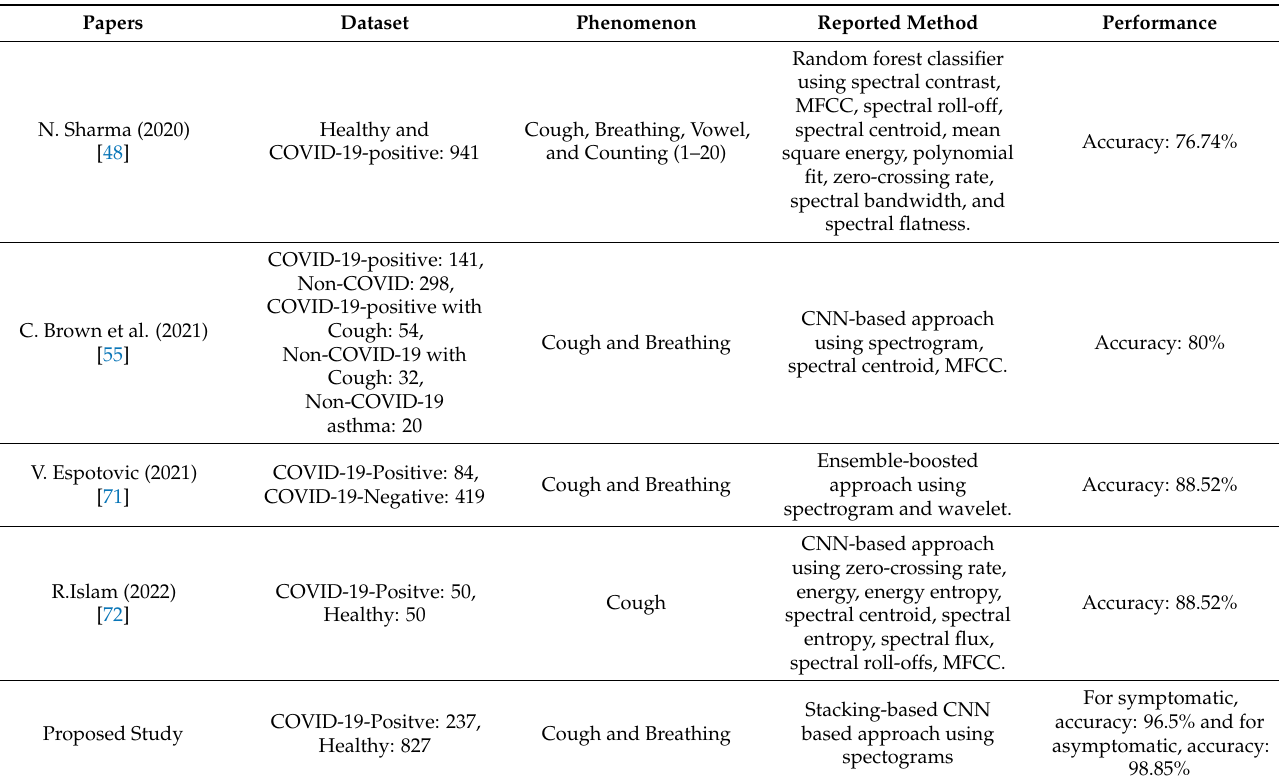
Table 6. Comparison of the proposed work with similar